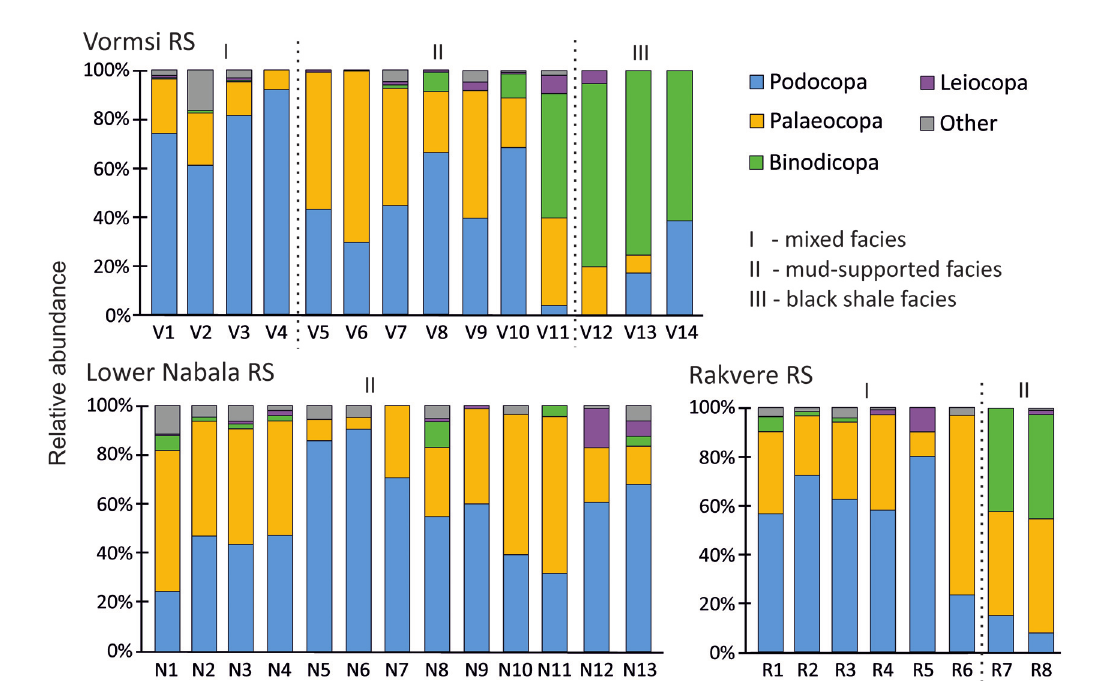
Fig. 7. Taxonomic distribution of ostracods in the analysed section intervals. Rakvere RS: R1 – Vinni, R2 – Laiamäe, R3 – Moe,